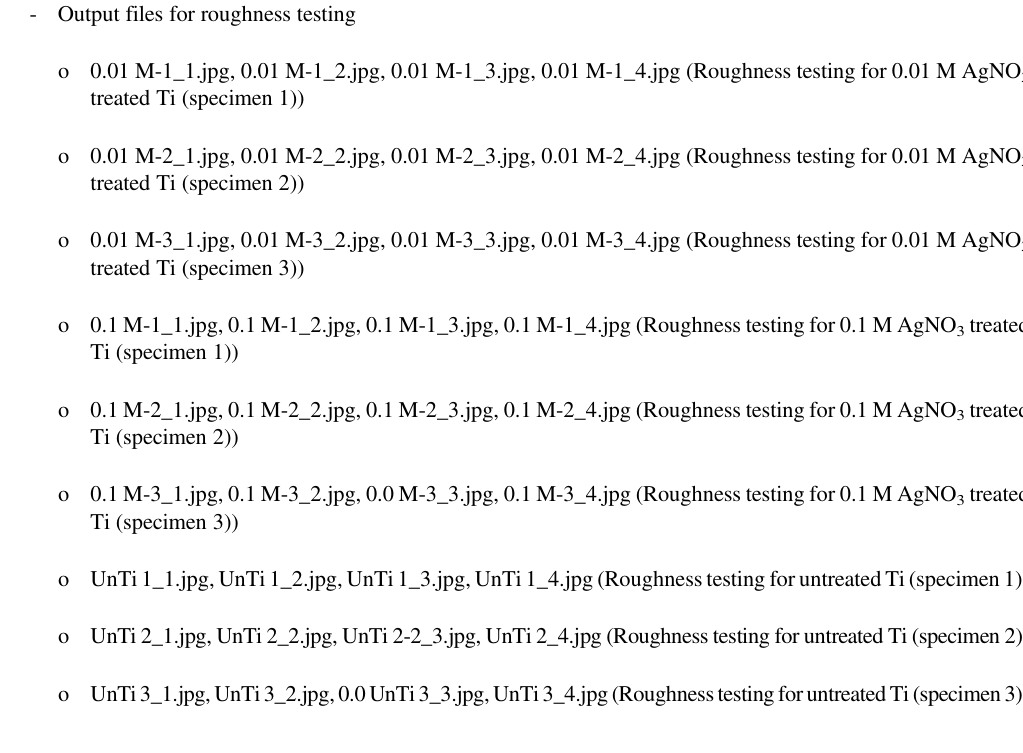
This project contains the following underlying data: